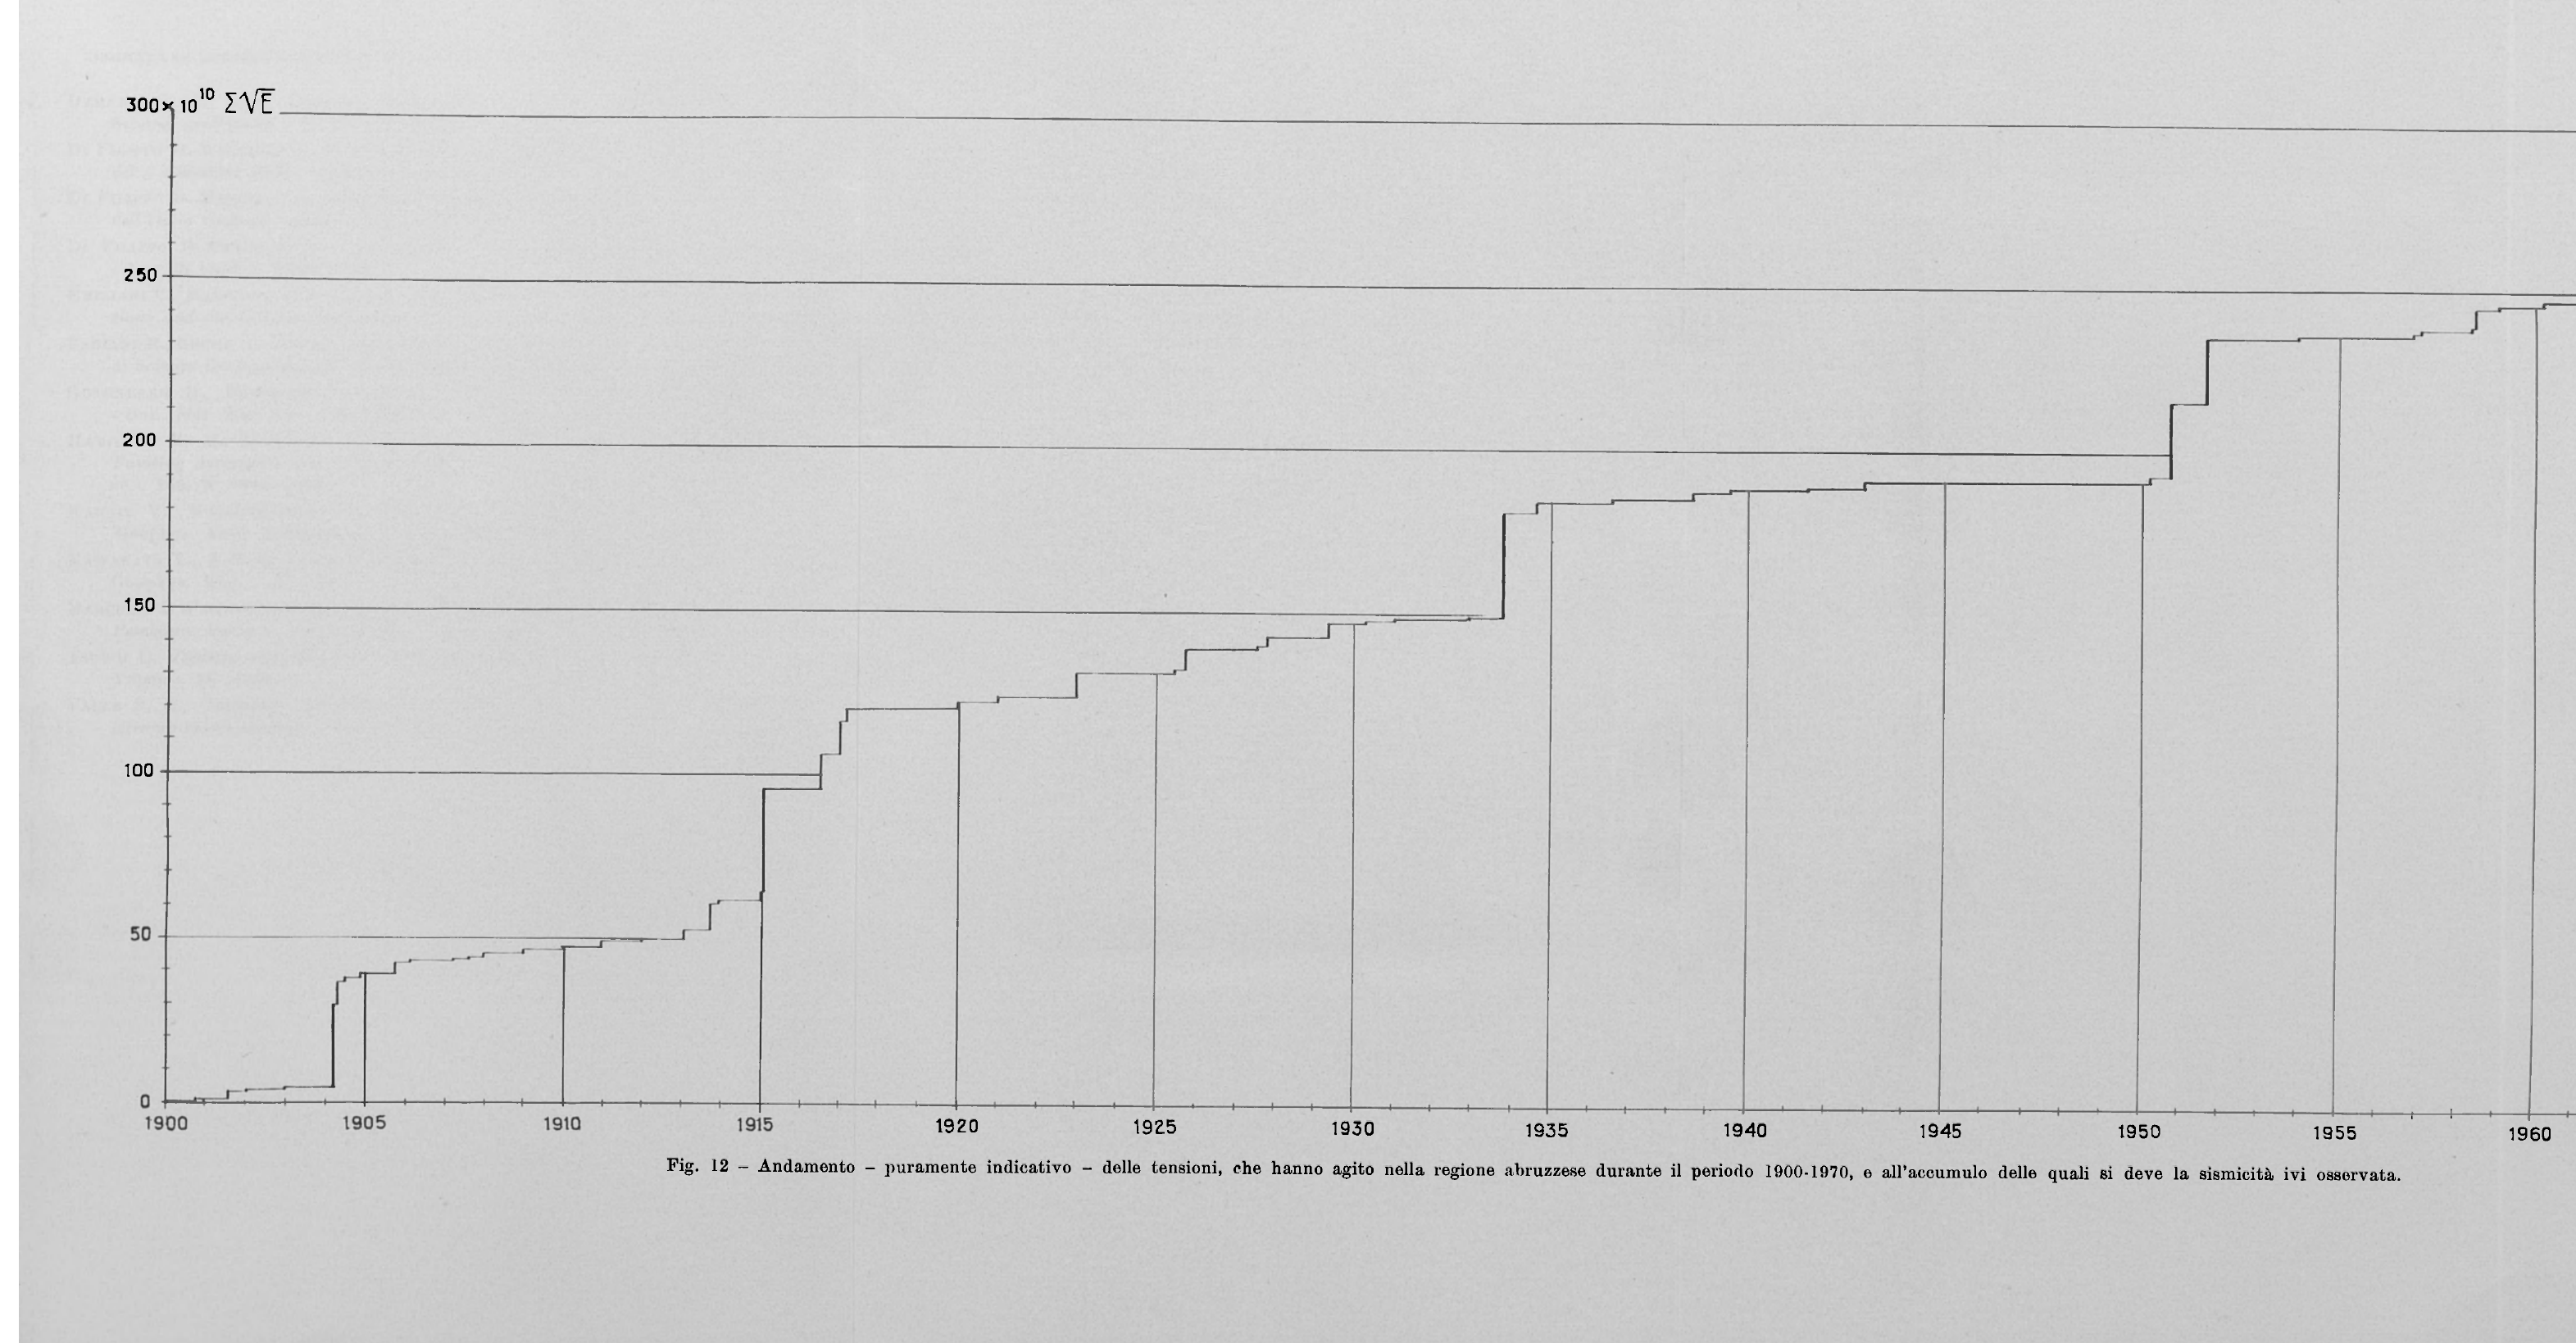
Fig. 12 - Andamento - puramente indicativo - delle tensioni, che hanno agito nella regione abruzzese durante il periodo 1900-1970, e all'accumulo delle quali si deve la sismicità ivi